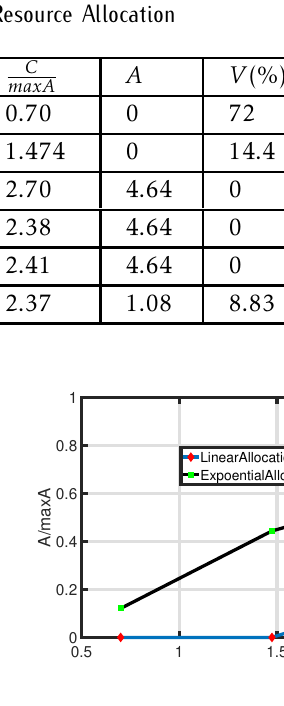
Figure 6. Linear and exponential cost allocation vs